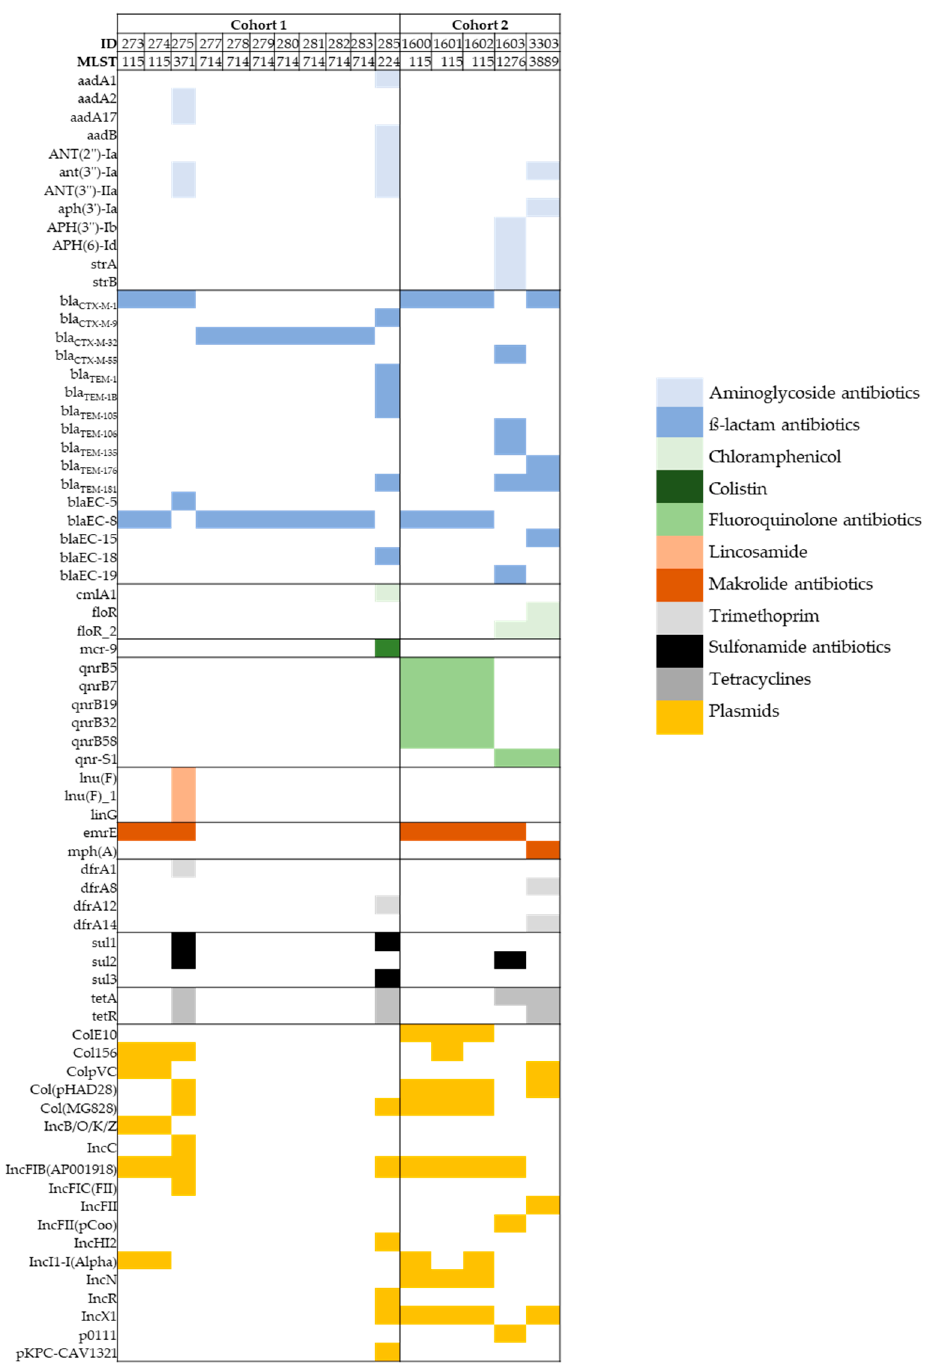
Figure 2. Presentation of genotypic data. Genetic data represent selected results from ABRicate (ARG-ANNOT, resfinder, megares, card, ncbi, plasmidfinder). The header lists the respective isolate number (ID) with the related multi-locus sequence type (MLST) (PubMLST). Resistance genes found in all isolates are not shown in the figure.